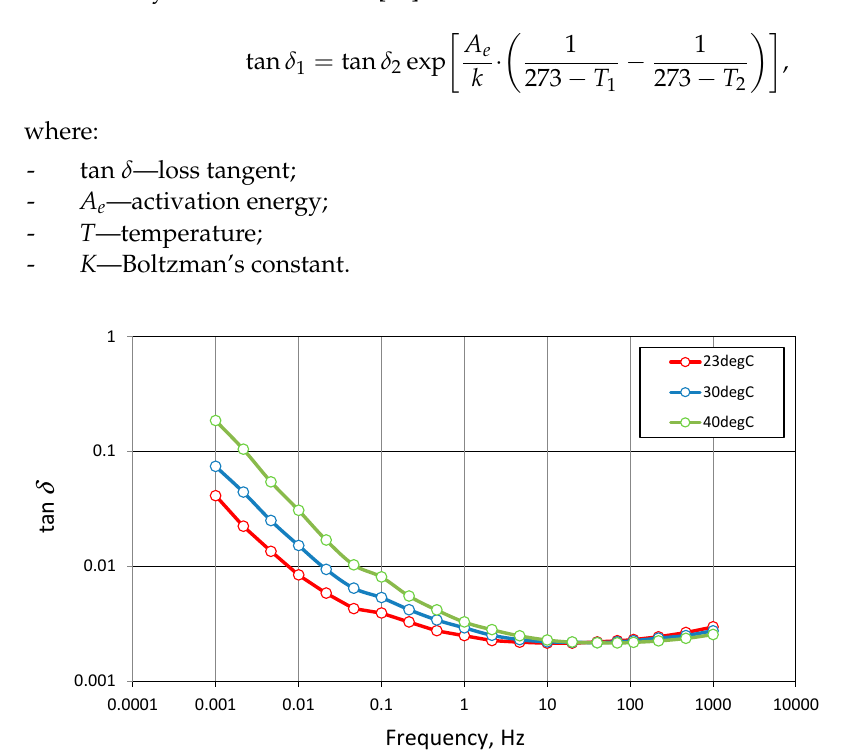
Figure 5. Dielectric response of the bushing insulation with uniform temperature distribution; measurements made for temperatures: 23 °C, 30 °C, and 40 °C.